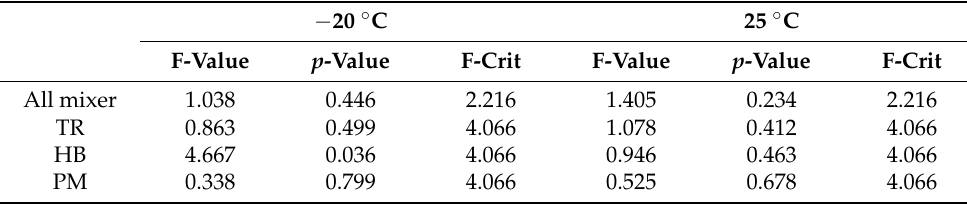
Table 11. One-way ANOVA of CT index results at − 20 and 25 ◦ C (significance level = 0.05).